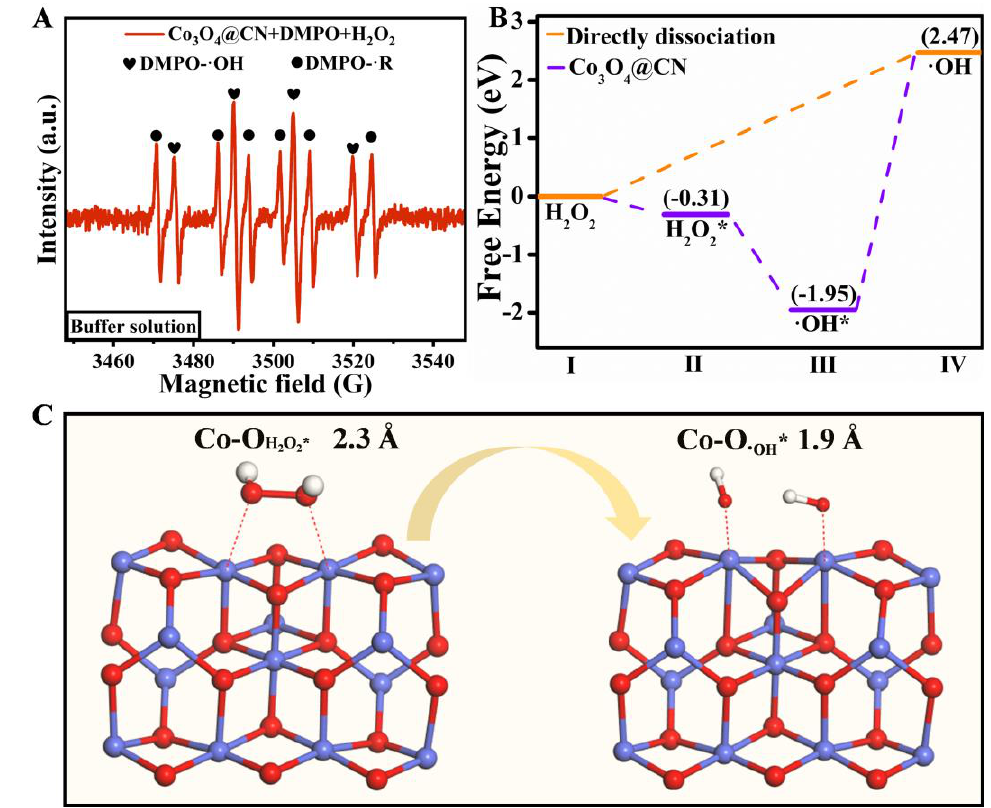
Figure 4. ( A )The ESR signal of Co 3 O 4 @CN in the buffer solution. ( B )The energy spectrum of the optimal pathway producing · OH. The ( C )DFT calculation of POD-like Activity of Co 3 O 4 @CN.